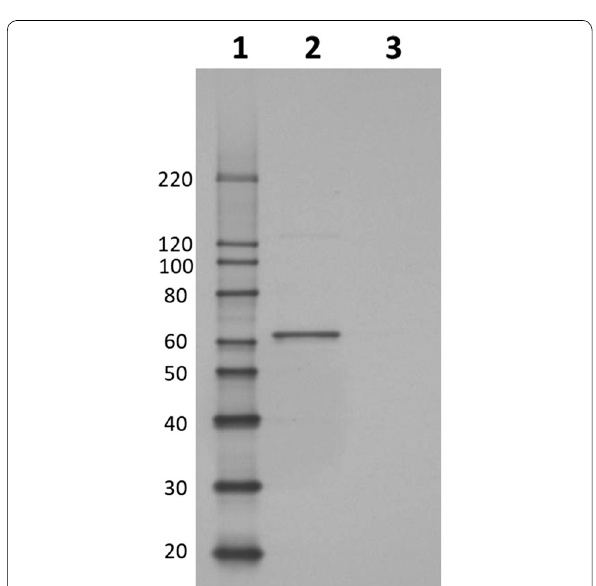
Fig. 2 Western blot image of whole-cell lysate from C. bescii expression strain JWCB018 pJOT1 showing a protein product of the size expected for heterologously expressed F. placidus benzoyl-CoA ligase protein as the major detected product. Whole-cell lysate was prepared, electrophoresed, and probed using anti-6 antibody (see methods). Lane 1: MagicMark XP Western Protein Standard (ThermoFischer Scientific, Waltham, MA) protein masses (in kDa) indicated adjacent to each band, Lane 2: Lysate from strain JWCB018 pJOT1, Lane 3: Lysate from strain JWCB018 pJGW07 (hosting an empty expression